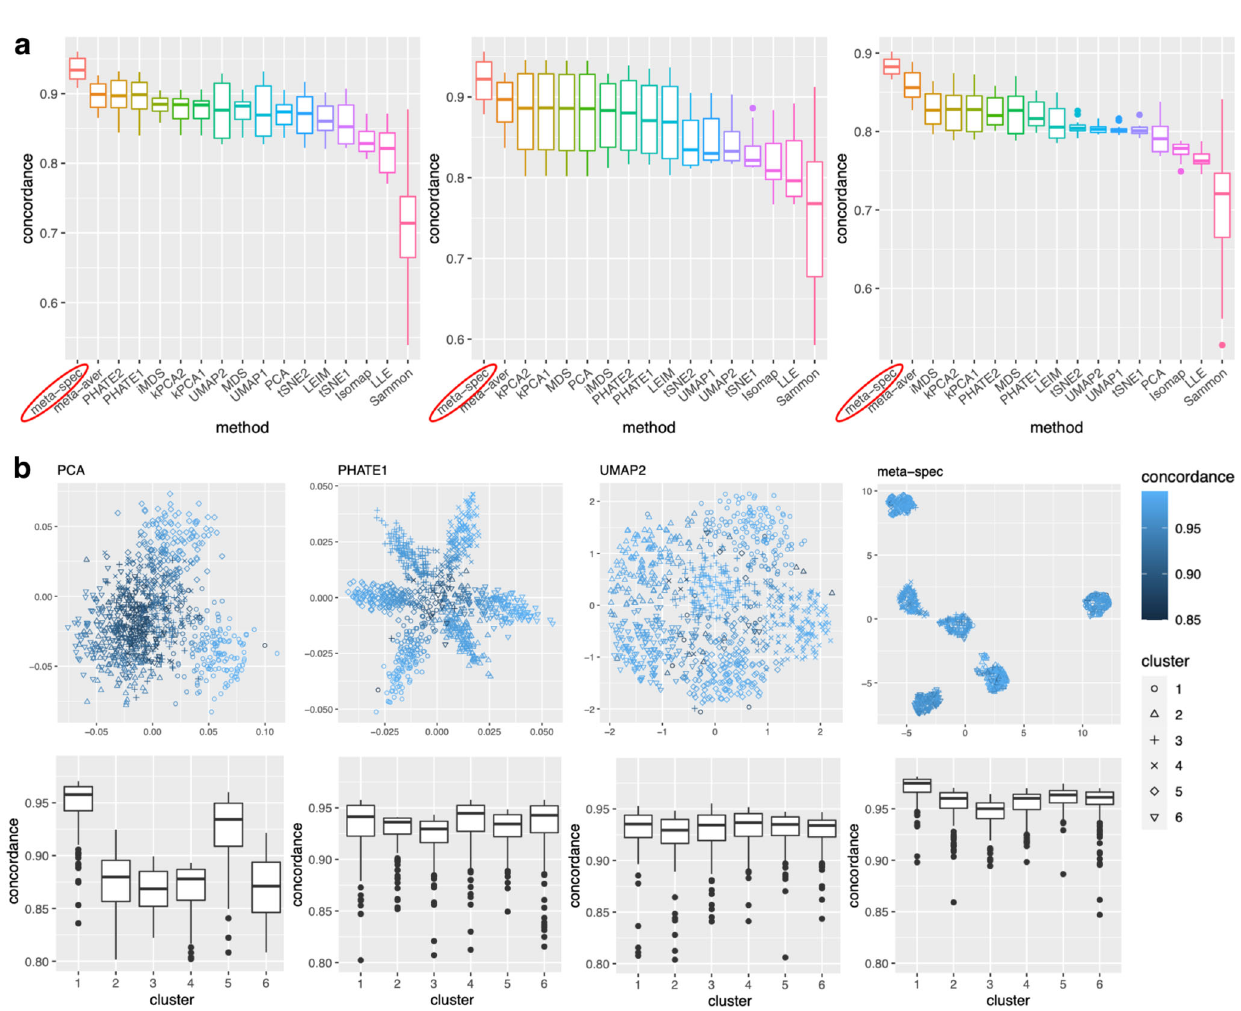
Fig. 2 | Results from simulation studies. a Boxplots (center line, median; box limits, upper and lower quartiles; points, outliers) of the mean concordance with the underlying true pattern for 15 candidate visualizations (HLLE omittted due to very low concordance) and the two meta-distance matrices under each simula- tion setting (Left: n =900 independent samples generated from the Gaussian mixture model; Middle: n =500 independent samples generated from the smiley face model; Right: n =500 independent samples generated from the mammoth model) across various values of the SNR value θ . See Supplementary Fig. 2 for